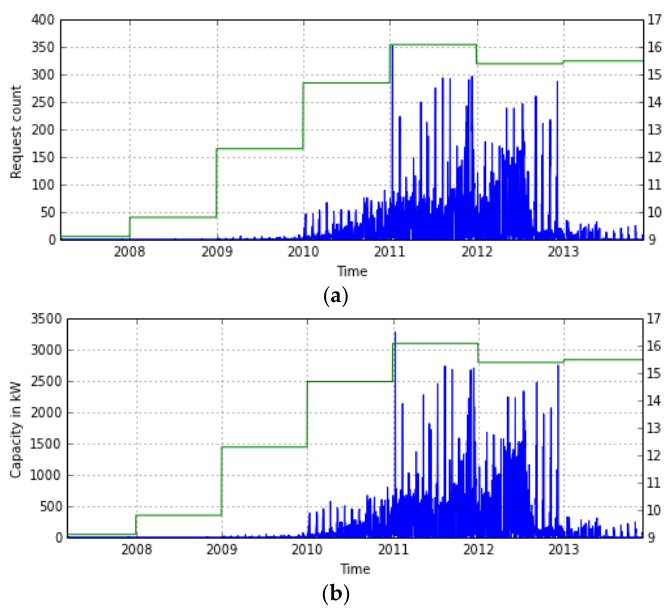
Figure 6. Evolution of demand and PI for rooftop PV investments from 2007 to 2013. ( a ) Number of grid connection requests for rooftop PV systems during March 2007 to December 2013; and ( b ) capacity that corresponds to grid connection requests for rooftop PV systems during March 2007 to December 2013.